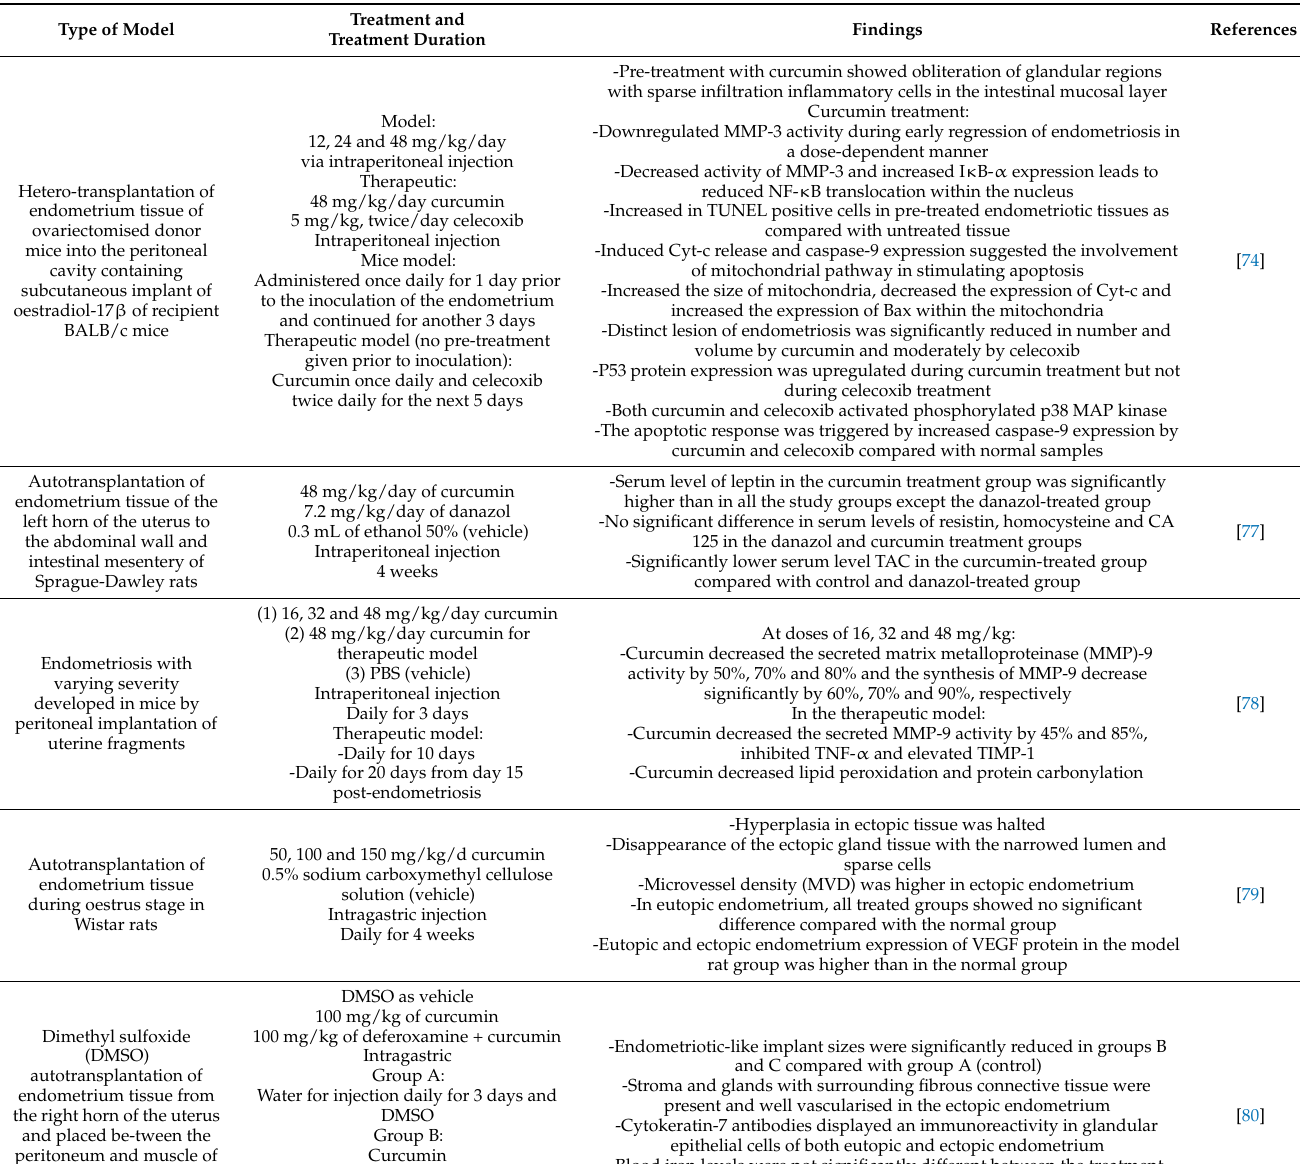
Table 4. Summary of the effects of curcumin on endometriosis in